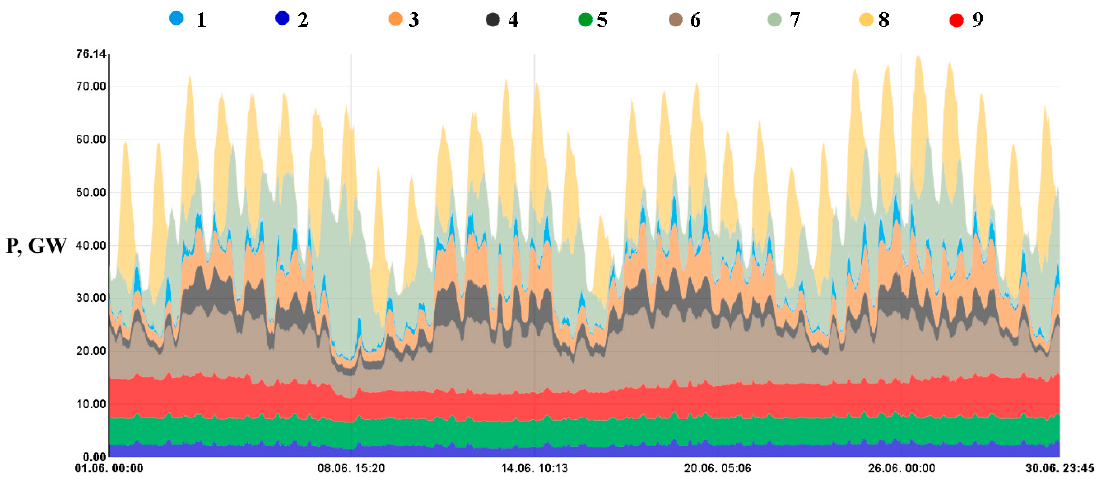
Figure 1. Generation of electric energy in the German electric power system, with division into sources, as of June 2019 (1—pumped-storage hydroelectric; 2—hydroelectric; 3—natural gas; 4—hard coal; 5—biomass; 6—lignite; 7—wind; 8—photovoltaic; 9—nuclear) [14].